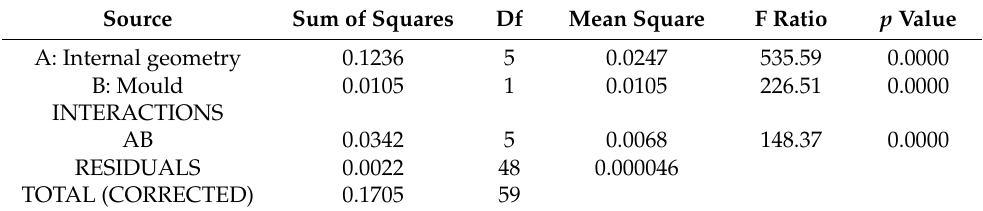
Table 6. ANOVA for ∆ W.